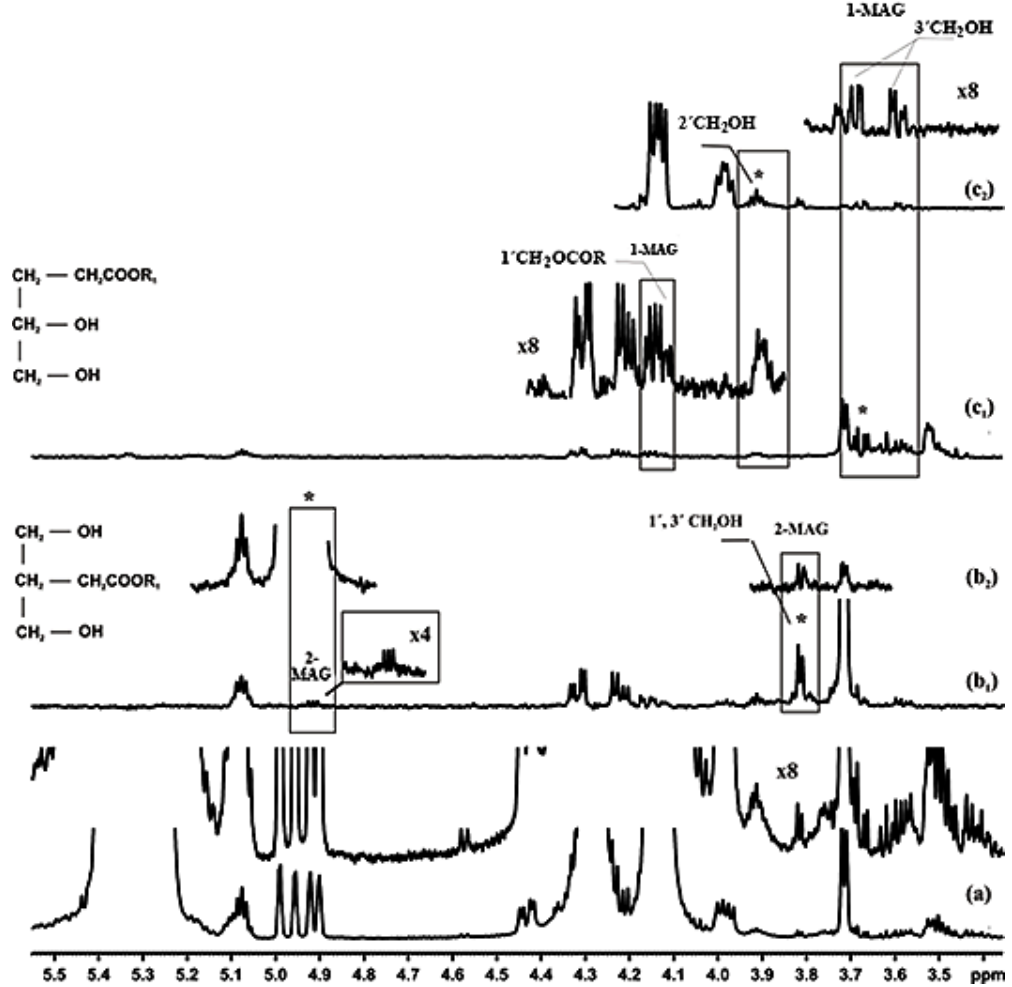
Figure 29. Selected regions of ( a ) Figure 28a, ( b ) 1D TOCSY spectrum that demonstrates the spin system of the glycerol moiety in 2-MAG (in panels b1 and b2, the selective excitation pulse was set on the 1 (cid:48) ,3 (cid:48) -CH 2 OH ( δ = 3.82 ppm) and 2 (cid:48) -CHOCOR ( δ = 4.92 ppm) peaks in 2-MAG, respectively), and ( c ) 1D TOCSY spectrum of the spin system of the glycerol moiety in 1-MAG (in panels c1 and c2, the selective excitation pulse was set on the 3 (cid:48) -CH 2 OH ( δ = 3.67 ppm) and 2 (cid:48) -CH 2 OH ( δ = 3.92 ppm) peaks in 1-MAG, respectively). Adopted, with permission, from [78]. Copyright 2015, American Chemical